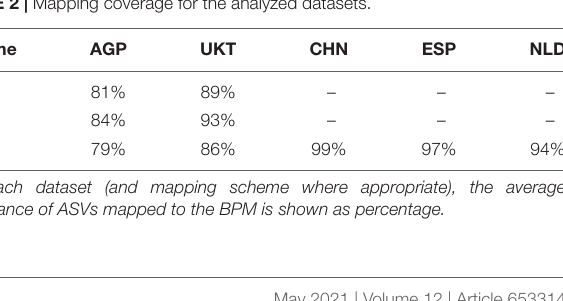
TABLE 2 | Mapping coverage for the analyzed